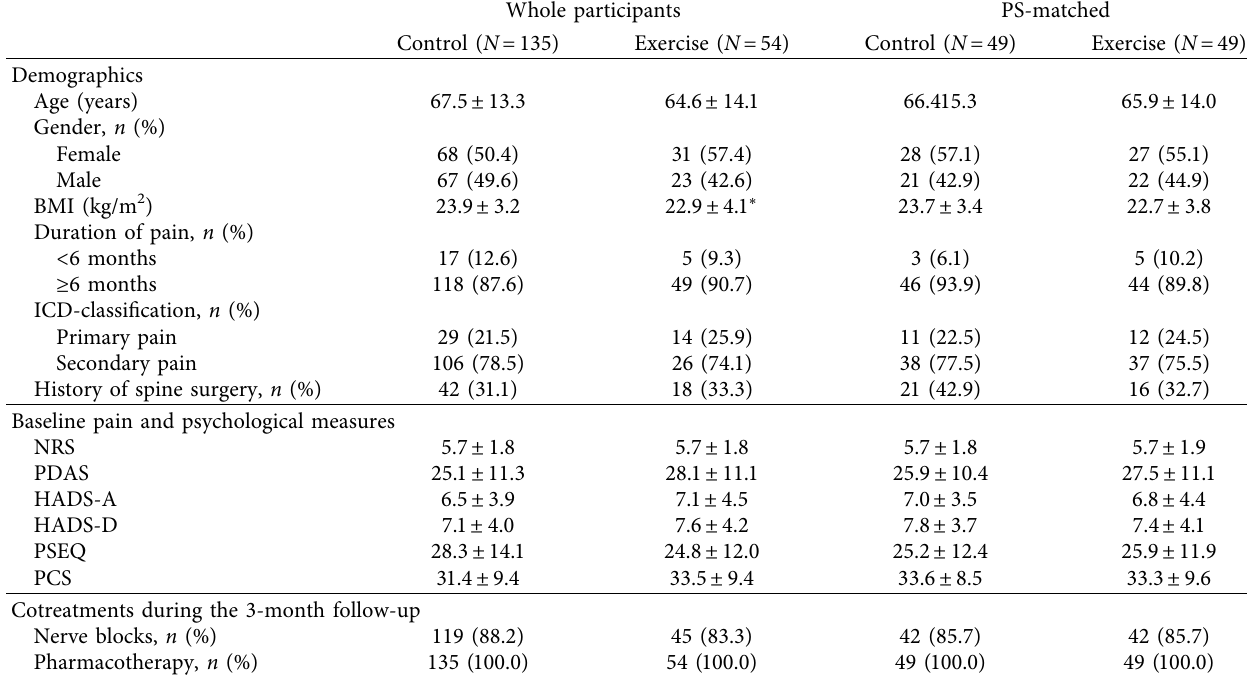
Table 1: Baseline characteristics and cotreatments before and after propensity score matching.